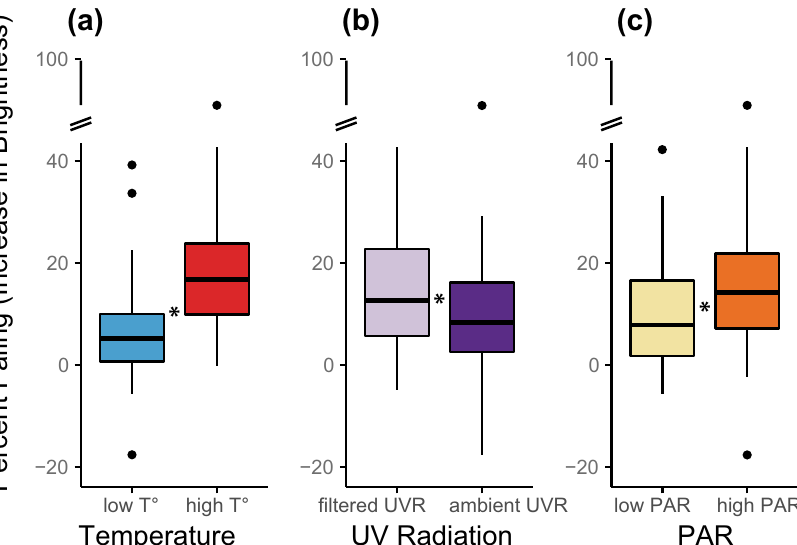
Figure 8. Some degree of coral paling occurred in all treatments between December 2017 and September 2018. However, corals paled significantly more at high temperature ( a ), when UVR was filtered out ( b ), and at high PAR levels ( c ). A star * means that the treatments were significantly different from each